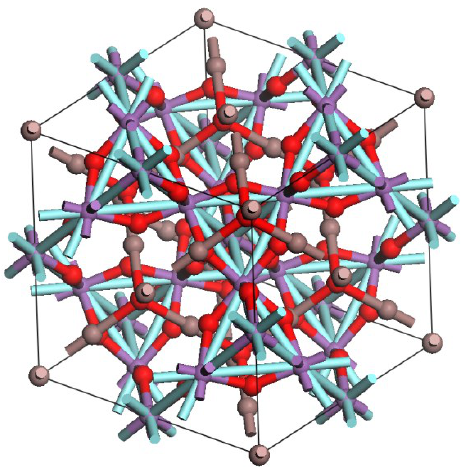
Figure 1. XRD pattern and Rietveld refinement of In 2 YSbO 7 (red dotted line represents experimental XRD data for In 2 YSbO 7 ; blue solid line represents simulated XRD data for In 2 YSbO 7 ; black solid line represents the difference between experimental and simulated XRD data for In 2 YSbO 7 ; green verti- cal lines indicate the observed reflection locations).